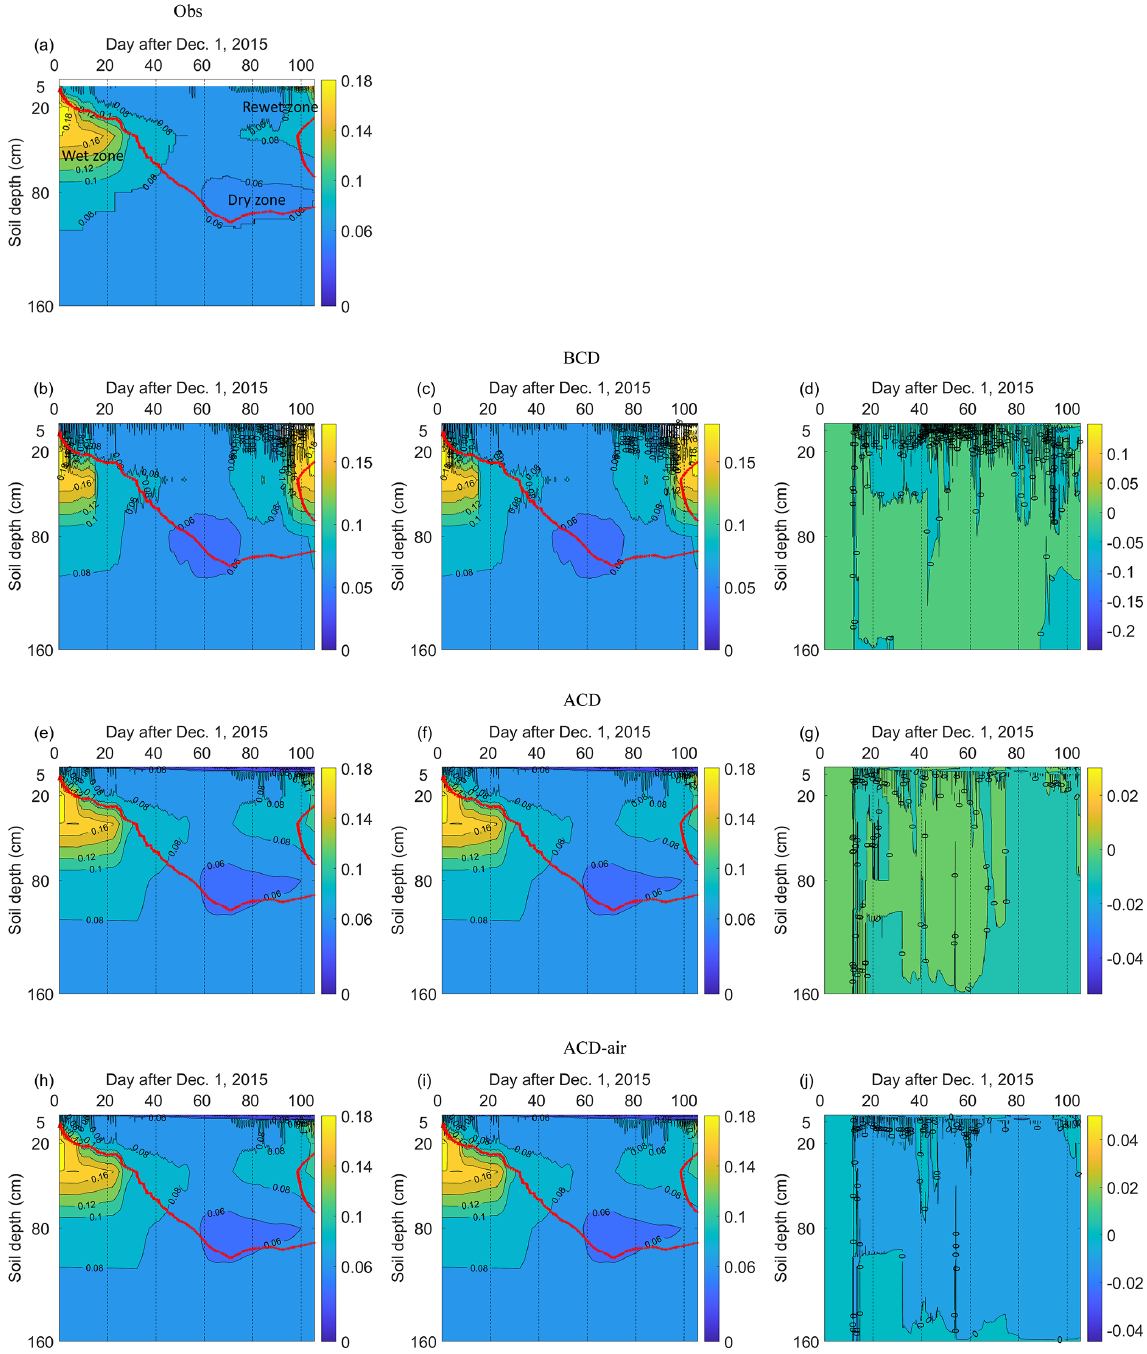
Figure 4. The spatial and temporal dynamics of observed (a) and simulated soil volumetric water content using BCD, ACD, and ACD-air soil models both with and without consideration of the snow module (snow: b, e, h ; no snow: c, f, i ) and the difference between them (d, g, j) (simulations with snow minus simulations without snow). The red line indicates the ZDIL from the measured soil temperature. The observed wet zone, dry zone, and rewet zone of soil moisture is indicated in Fig.